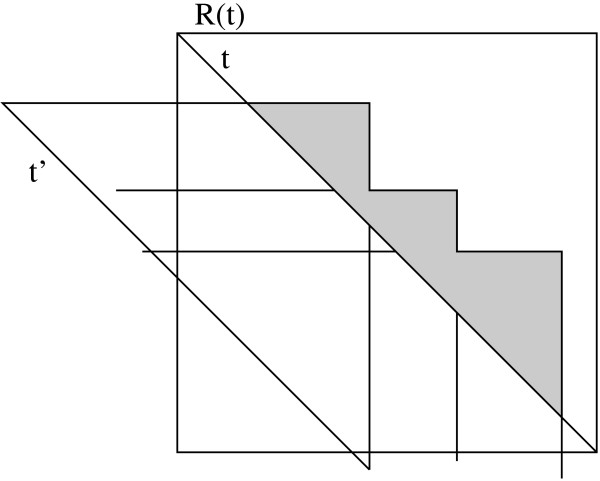
The grey area denotes the basic intersection staircase, which describes the maximal cliques which potentially must not be considered since they have been considered already during the computation of the maximal cliques for hypotenuses like t' lower than t. In the example, we have three diagonals t' lower than t whose rectangles r (t') intersect t.